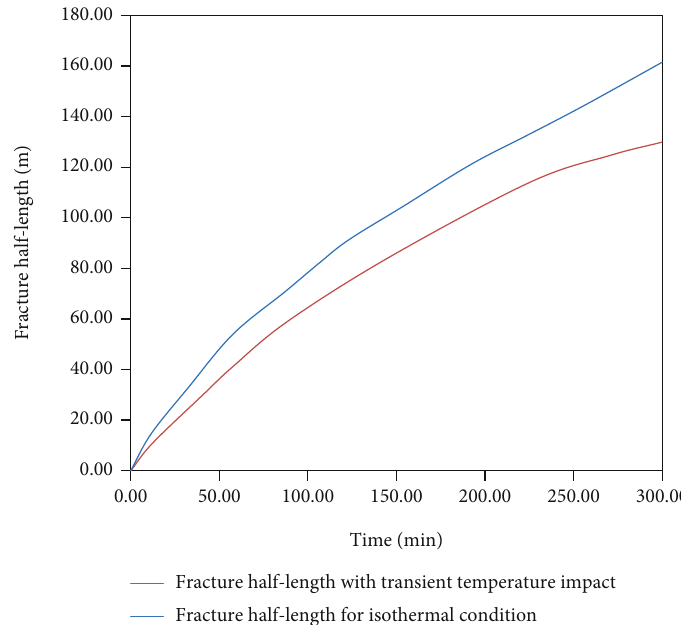
Figure 5: Comparison of fracture half-length between the isothermal fracture model and the transient heat fracture propagation model.